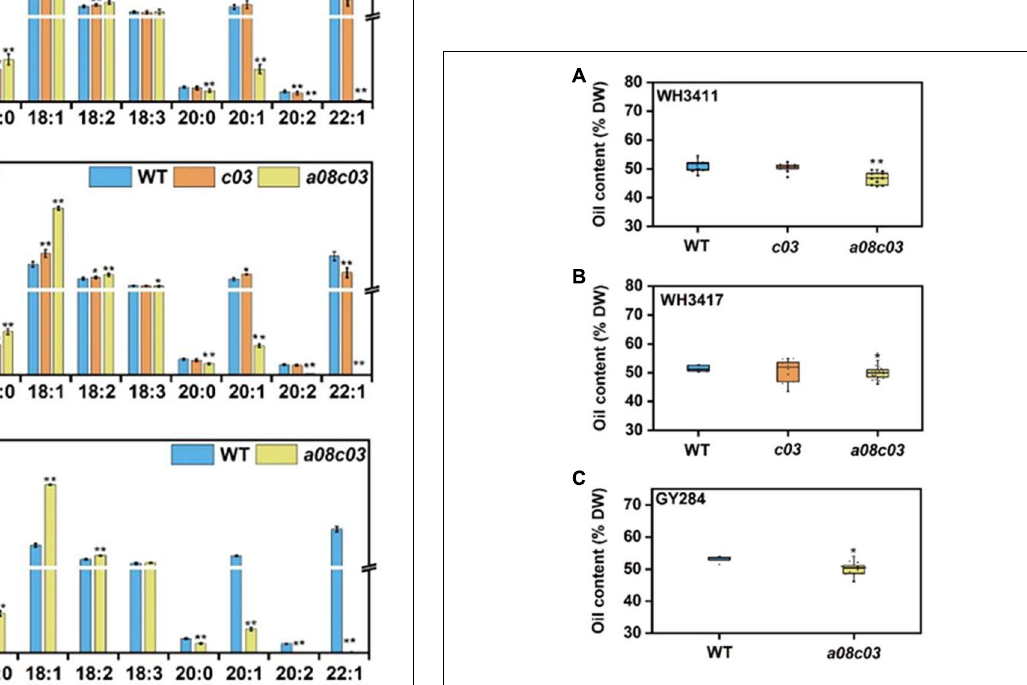
Frontiers in Plant Science |